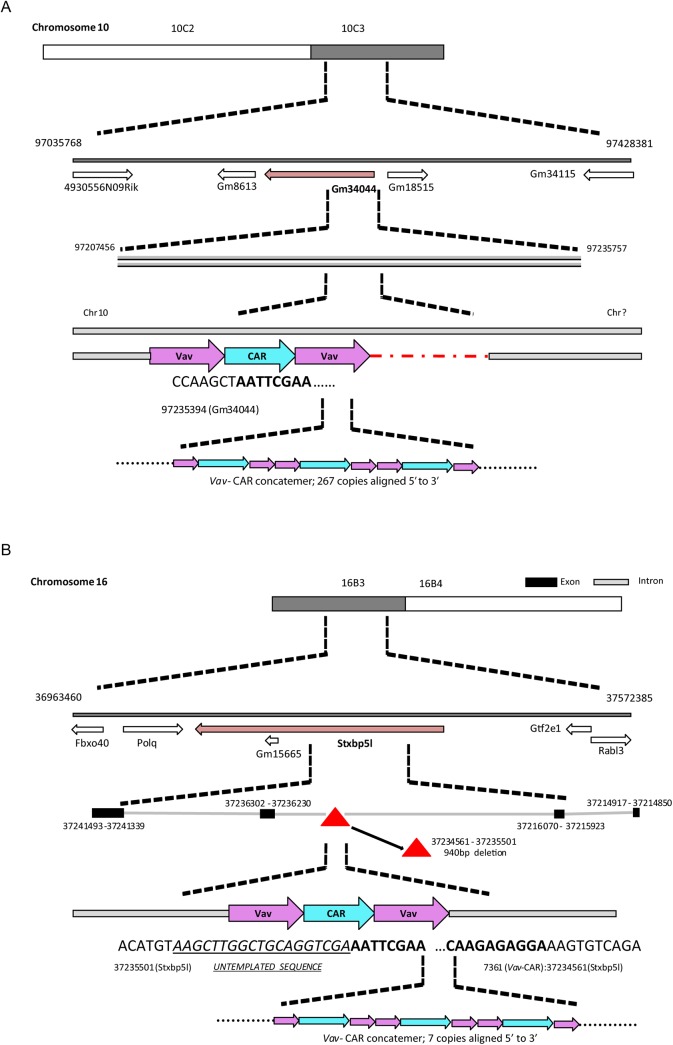

Vav-CAR insertion site for F9 (Chr10) and F38 (Chr16) mice.Schematic depicting the transgene integration site for A) F9 and B) F38 mice. A) The entry point for F9 mice was found at position 97235394 on the negative strand on Chromosome 10 within the predicted pseudo gene Gm34044. The exit point for this strain was not found. B) The entry point for F38 mice was found at position 37235501 on Chromosome 16 within the Stxbp5l gene. The exit point was found 942bp upstream, at position 37234561, resulting in a 940bp deletion of the Stxbp5l gene. A region of untemplated sequence (underlined) was observed preceding the transgene at the entry point. In both strains, the transgene had formed a concatemer, with A) 267 copies in F9 mice and B) 7 copies in F38 mice. The fusion position between the native mouse genome (regular font) and the vav-CAR transgene (bold) can be seen at nucleotide level.